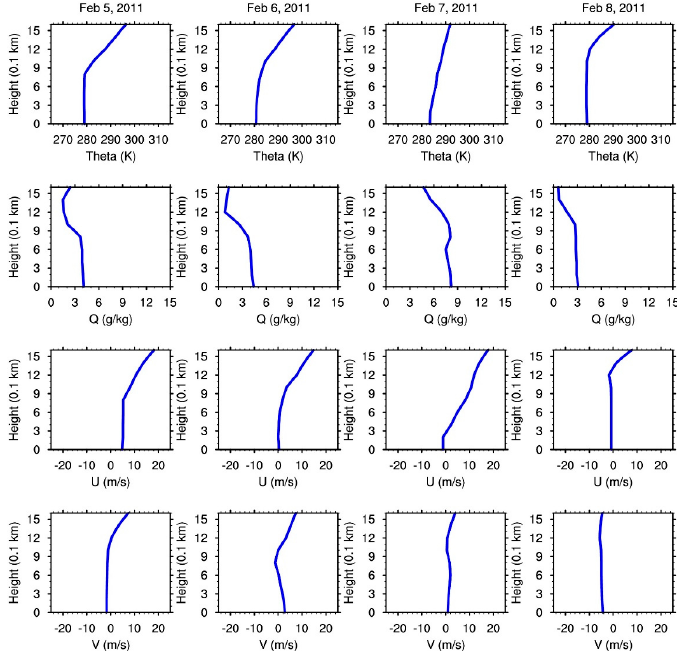
Figure 4. Vertical profiles of potential temperature (K) ( top ), specific humidity (g/kg) ( second row ), westerly and southerly wind components (m/s) ( third and fourth rows ) at Eglin simulated with WRF. The columns from left to right are 5–8 February 2011 at noon local time.